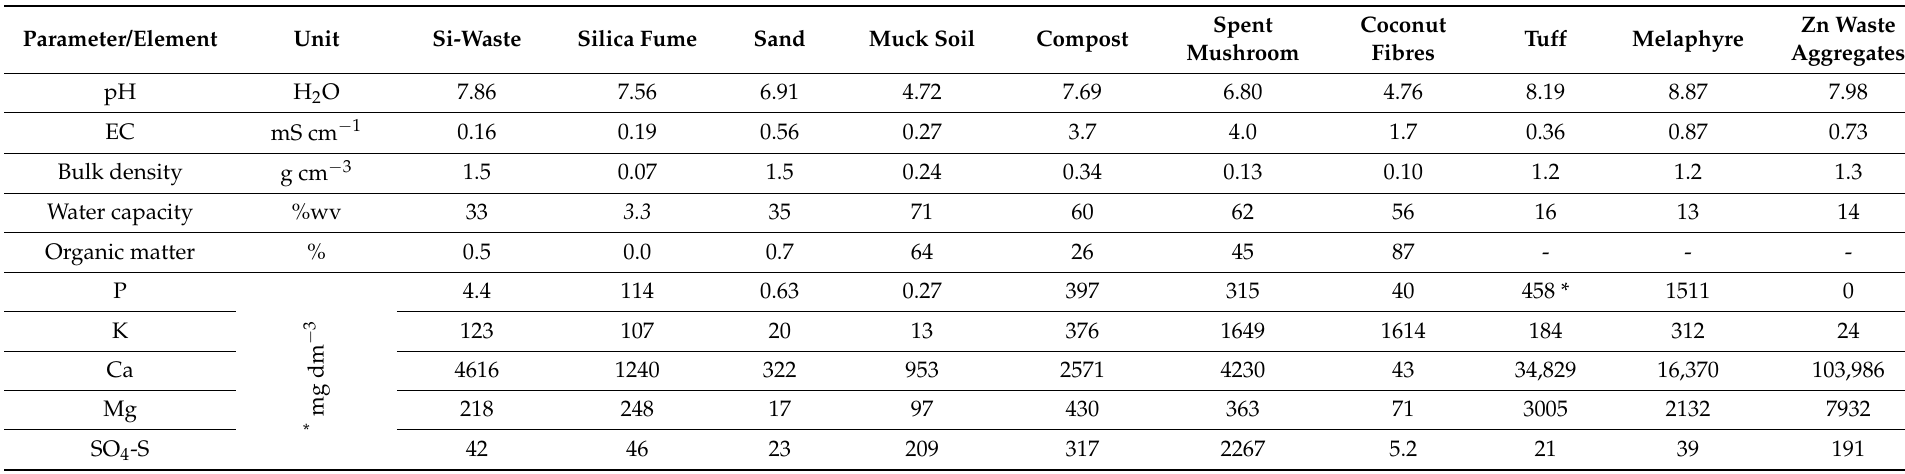
Table 3. Physical and chemical properties of green roof substrate